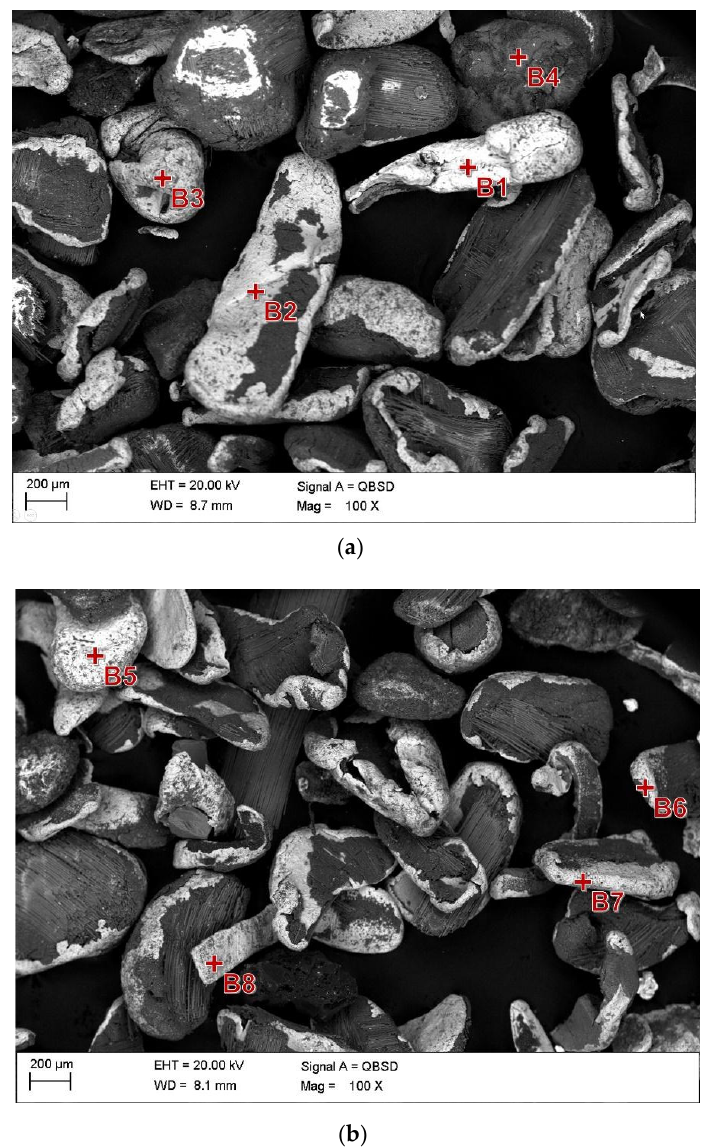
Figure 6. Intermediate from the electrostatic separation (SEM, QBSD mode (Table 5)) with marked